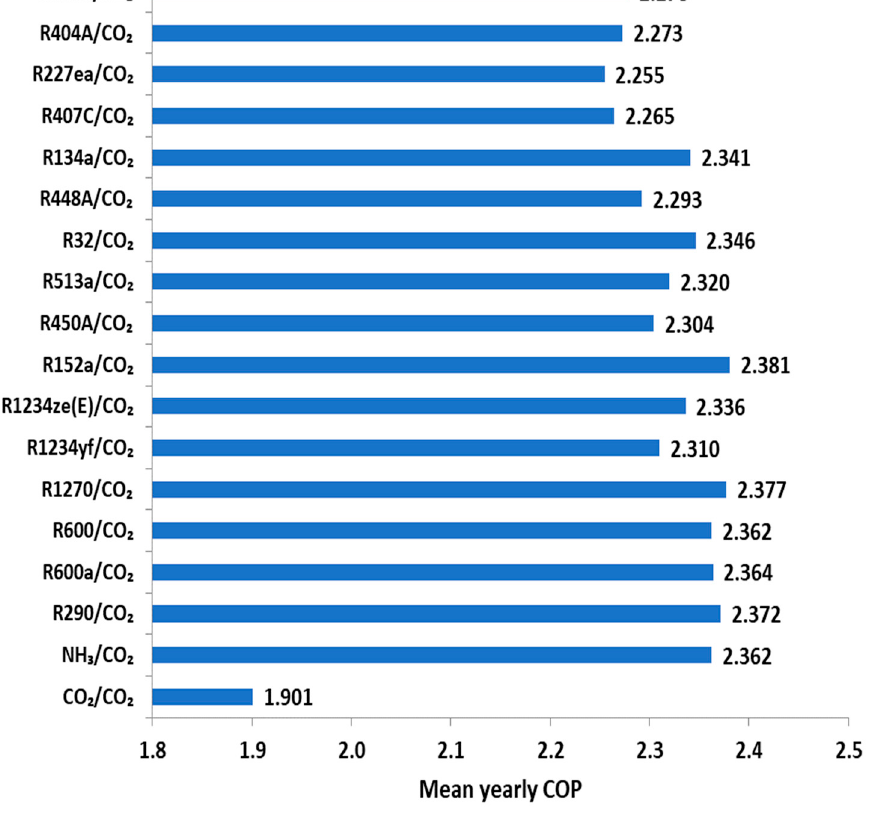
Figure 8. Mean yearly COP of the examined systems for T e = − 35 °C.